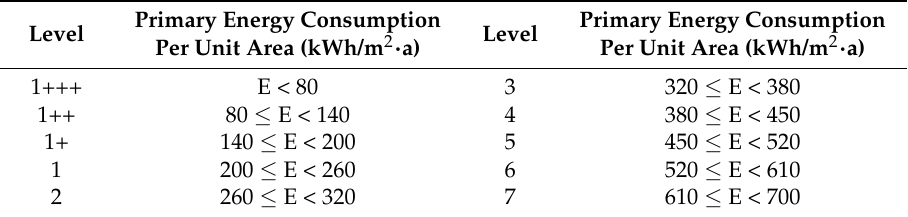
Table 2. The building energy efficiency certification system in Korea (for non-residential buildings).